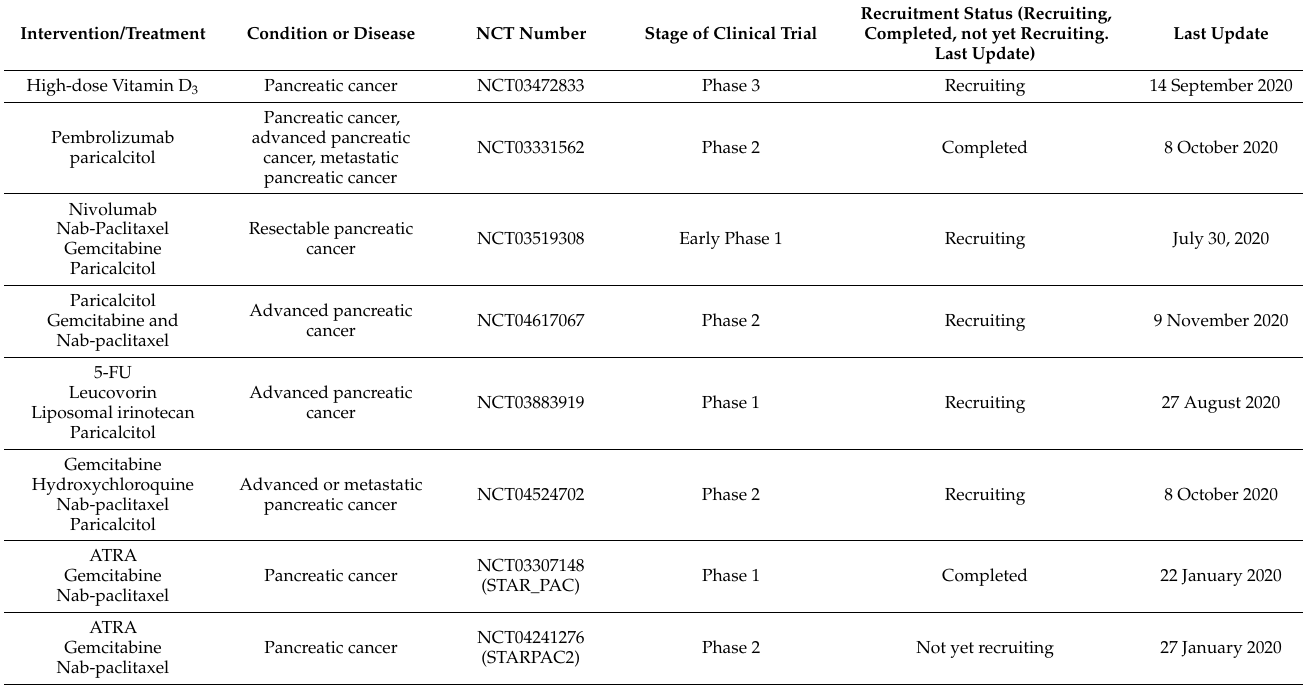
Table 4. Overview of clinical trials for reprogramming active fibroblasts into quiescent fibroblasts or tumor-promoting cancer-associated fibroblasts into tumor-restraining cancer-associated